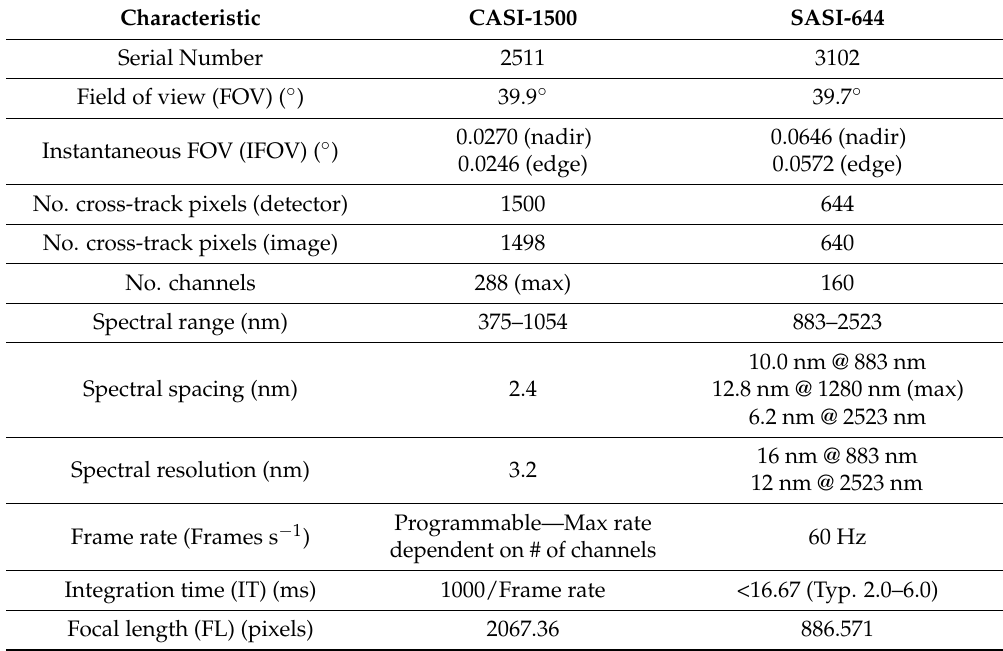
Table 1. Summary of the Compact Airborne Spectrographic Imager (CASI-1500) and Shortwave Airborne Spectrographic Imager (SASI-644) characteristics.